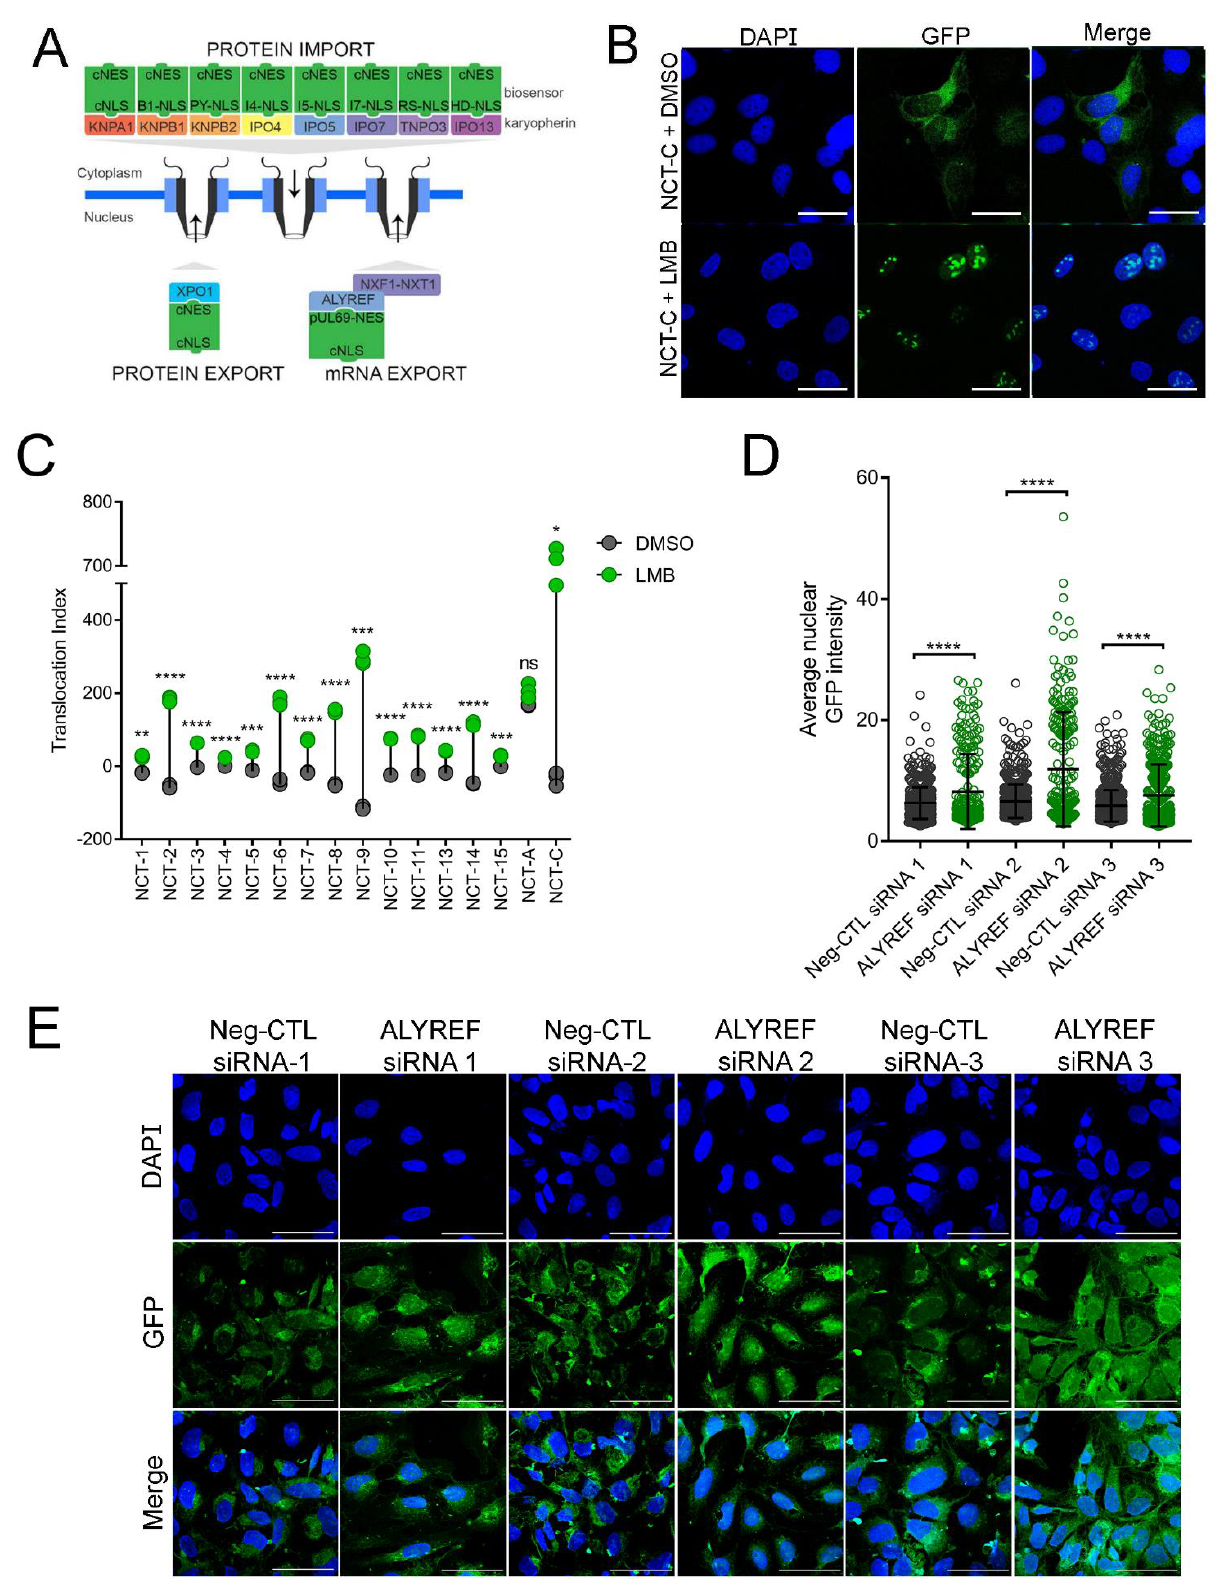
Figure 1. Nucleocytoplasmic transport biosensors are functional. ( A ) Schematic of biosensor design—a green fluorescent protein fused with different classes of nuclear localization signals (NLSs) and the classical nuclear export signal (cNES) or the Aly/REF recognition motif. ( B ) Representative confocal images of cells expressing the NCT-C biosensor (green) under control conditions (DMSO) and after exposure to leptomycin (LMB) (2 h at 2 ng/mL). Scale bar = 40 µm. ( C ) Dot plot of